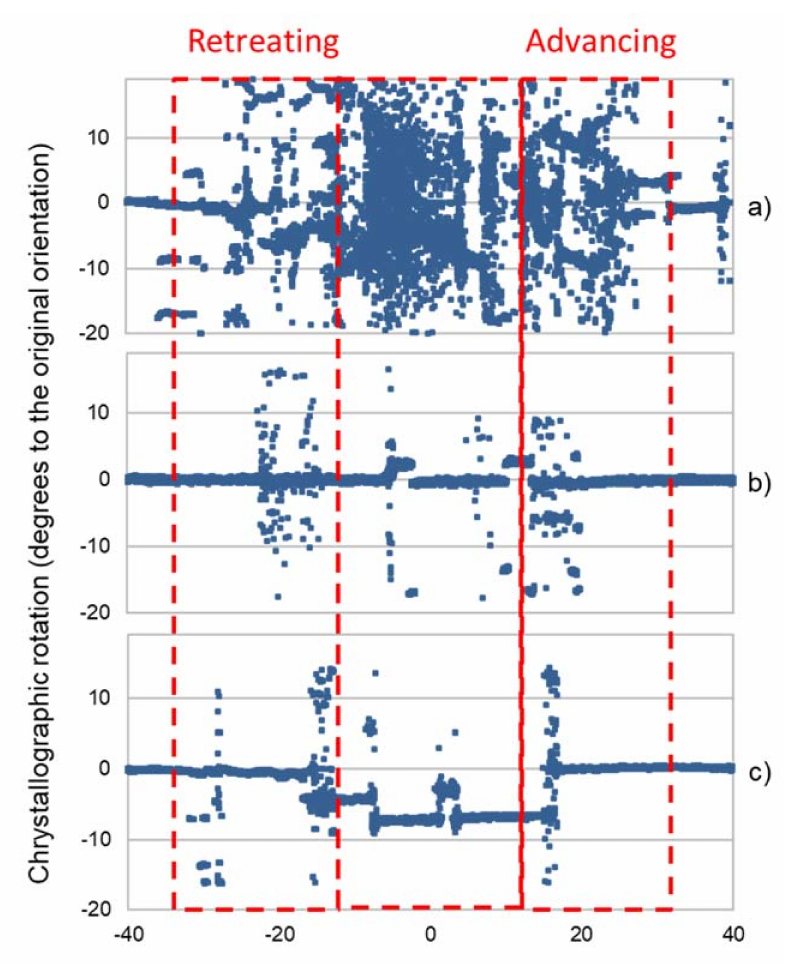
Figure 6. Reassembly of the microstructure after welding as atoms rotate from the original orientation particles for v/wr = ( a ) 8.33 × 10 1 , ( b ) 8.33 × 10 0 , and ( c ) 8.33 × 10 − 1 . The rotation (degrees) is represented for a cross-section along the welded material after system